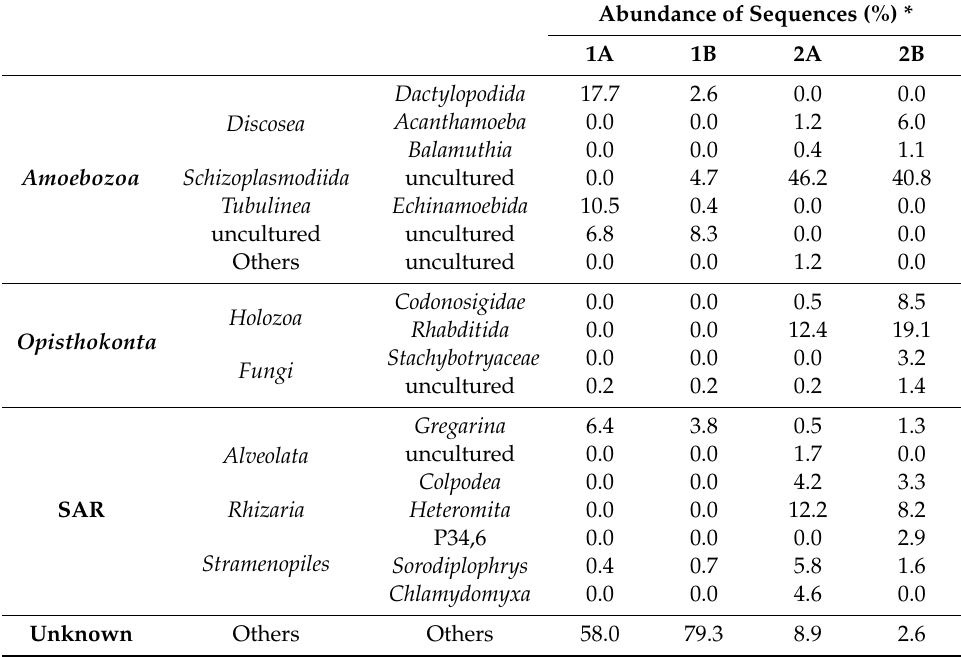
Table 2. Relative abundance of eukaryotes, with higher taxonomic level in bold and lower taxonomic levels in